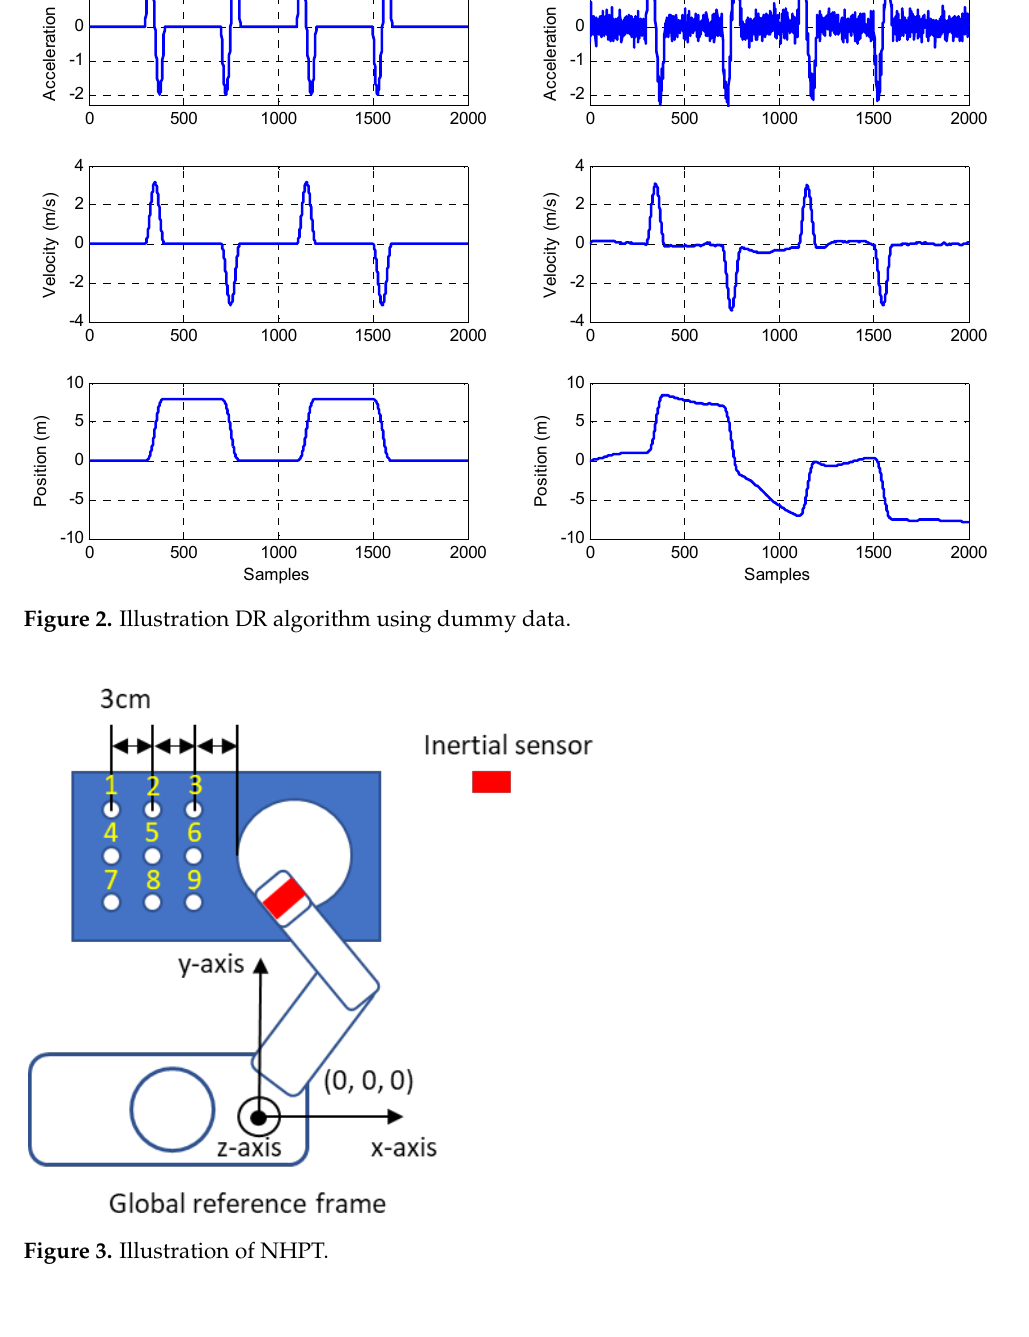
Figure 4. Errors in position tracking using DR algorithm for NHPT. This is because the integration or summing of the acceleration signal to calculate ve- locity will integrate/sum any error in the estimate of offset. This error will increase in di- rect proportion to the measurement time and sample rate. If the DC offset is not removed from acceleration output or velocity calculation, the effect of errors in the estimation of offset of the position will follow a square law relationship with time and sample rate. Equation (4) shows how the error in the estimate of velocity is proportional to the acceleration error, offsets and time of measurement and the error in the estimate of the position is proportional to the square of the elapsed time. 0